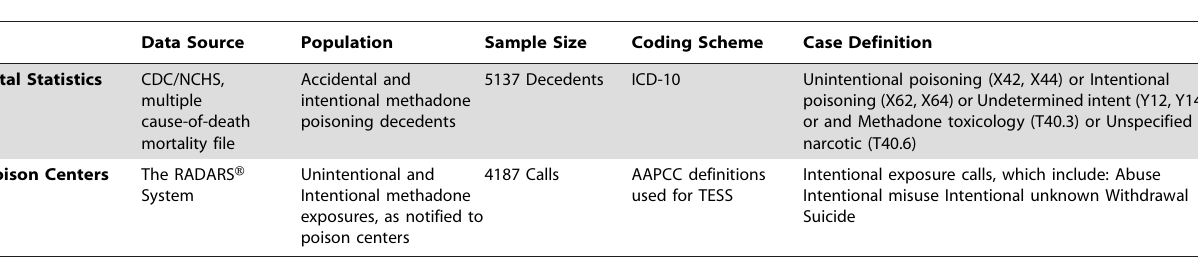
Table 1. Data sources and definitions used in analysis, 29 states, 2006–2007.